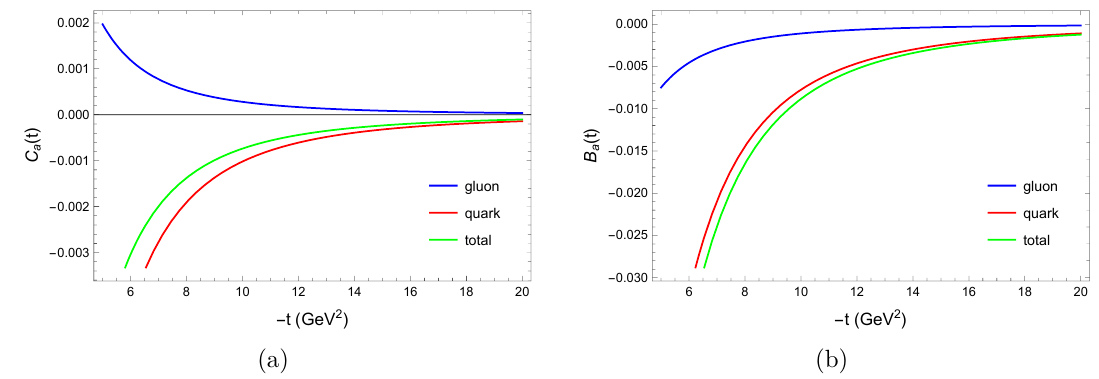
Figure 4. Nucleon GFFs with nucleon DAs estimated from QCD sum rule [81, 98]. Here we take the soft scale Λ c = 200 MeV to regulate the end-point singularities associated with the nucleon helicity flip amplitude to extract the GFFs.